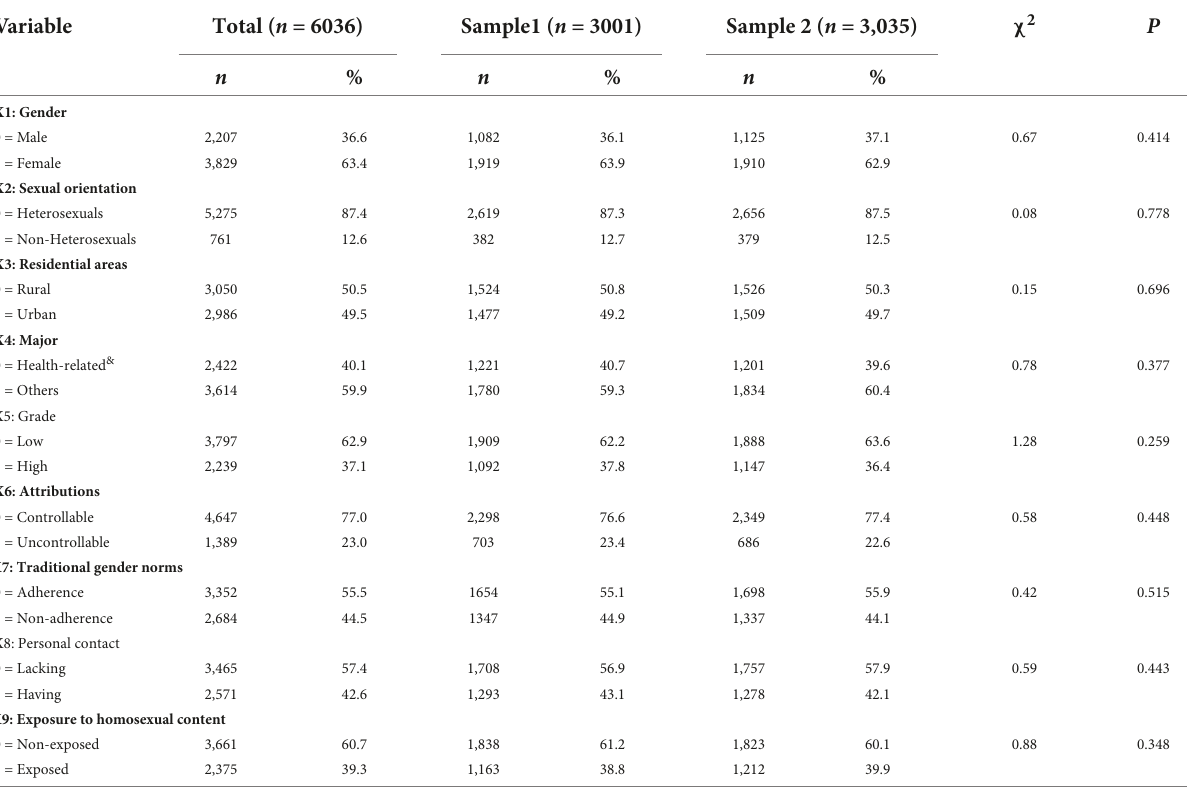
TABLE 2 Social-demographic characteristics and homosexuality-related values, beliefs and behaviors of the 6,036 undergraduates in mainland China. Variable Total ( n = 6036) Sample1 ( n = 3001) Sample 2 ( n =